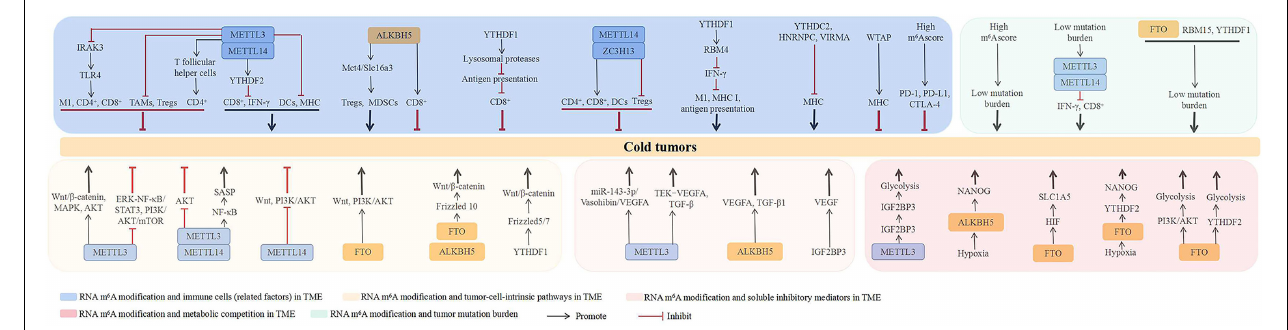
FIGURE 3 | The potential roles of RNA m 6 A modification in cold tumors. The mechanisms underlying RNA m 6 A modification-mediated cold tumors include regulating the immune cells in TME, targeting tumor-cell-intrinsic pathways, facilitating soluble inhibitory mediators in TME, increasing metabolic competition in TME, and affecting tumor mutation burden. ALKBH5, ALKB homolog 5; CTLA-4, cytotoxic T-cell lymphocyte-associated protein 4; DCs, dendritic cells; FTO, fat mass and obesity-associated protein; HNRNP, heterogeneous nuclear ribonucleoprotein; M1, M1 macrophages; MDSCs, myeloid-derived suppressor cells; METTL, methyltransferase-like; MHC, major histocompatibility complex class; NF- κ B, nuclear factor kappa-B; HIF, hypoxia-inducible factor; IFN- γ , interferon γ ; IRAK3, IL-1 receptor-associated kinase 3; IGF2BP, insulin-like growth factor-2 mRNA-binding protein; PD-1, programmed death receptor 1; PD-L1, programmed death receptor ligand 1; RBM, RNA-binding motif; SASP, senescence-associated secretory phenotype; TAMs, tumor-associated macrophages; TGF- β , transforming growth factor- β ; TLR4, toll-like receptors 4; Tregs, regulatory T cells; VEGF, vascular endothelial growth factor; VIRMA, vir-like m 6 A methyltransferase associated; WTAP, Wilms’ tumor 1-associated protein; YTHDC2, YT521-B homology domain-containing protein 2; YTHDFs, YT521-B homology domain-containing family; ZC3H13: zinc finger CCCH-type containing